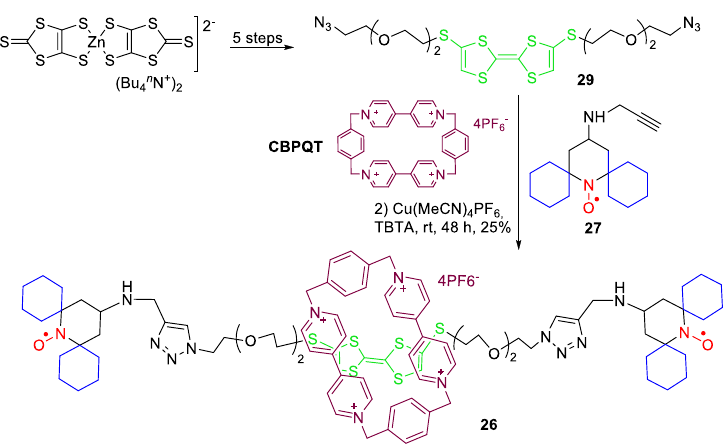
Scheme 6. Synthesis of [2]rotaxane 26 via a three-component Cu(I)-catalyzed click reaction among SNR 27 , TTF derivative 29 carrying azide-terminated glycol chains, and CBPQT.